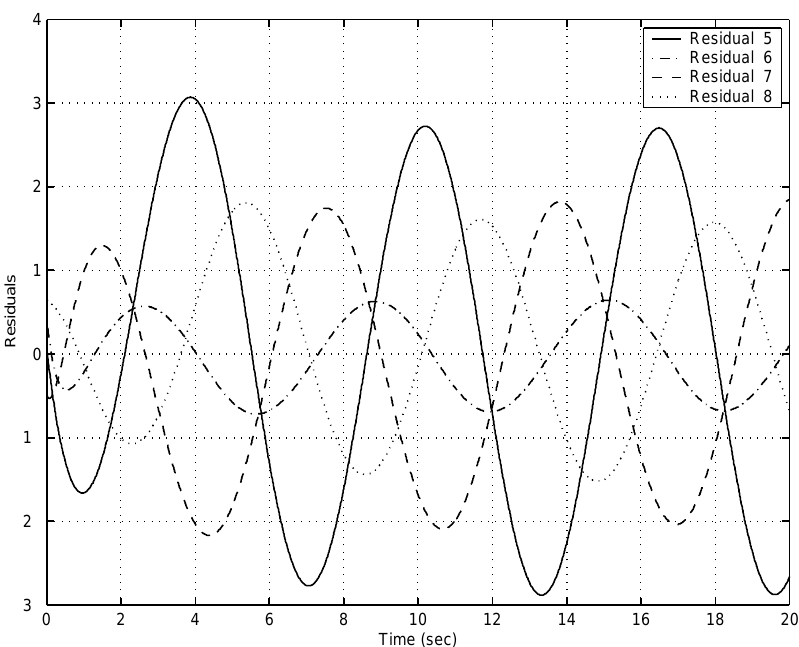
Fig. 14. Residuals 5-8 for 4 mode simulation with δ 1 = 0 . 01